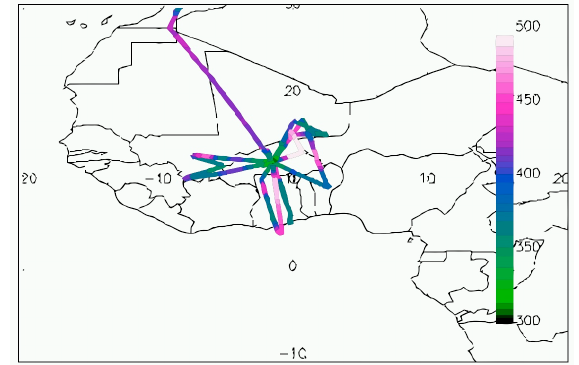
Figure 1: M55 flight tracks over West Africa, colour coded in potential temperature (K) along the flights. 3